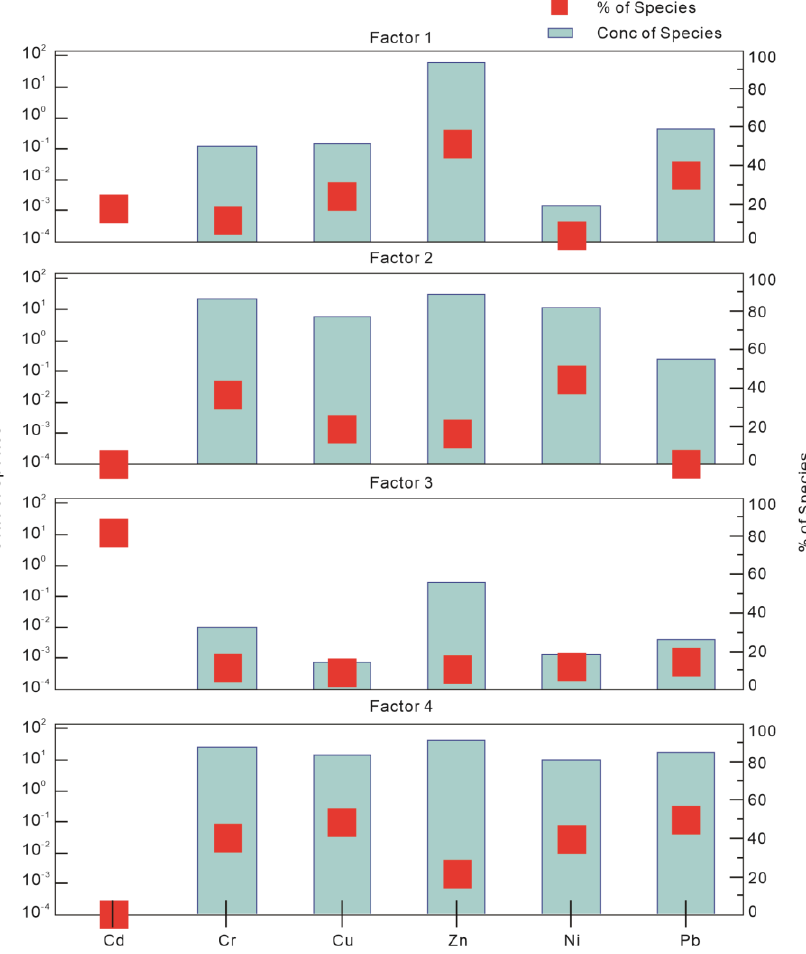
Figure 5. Pollution source diagram of heavy metal PMF analysis in study area.